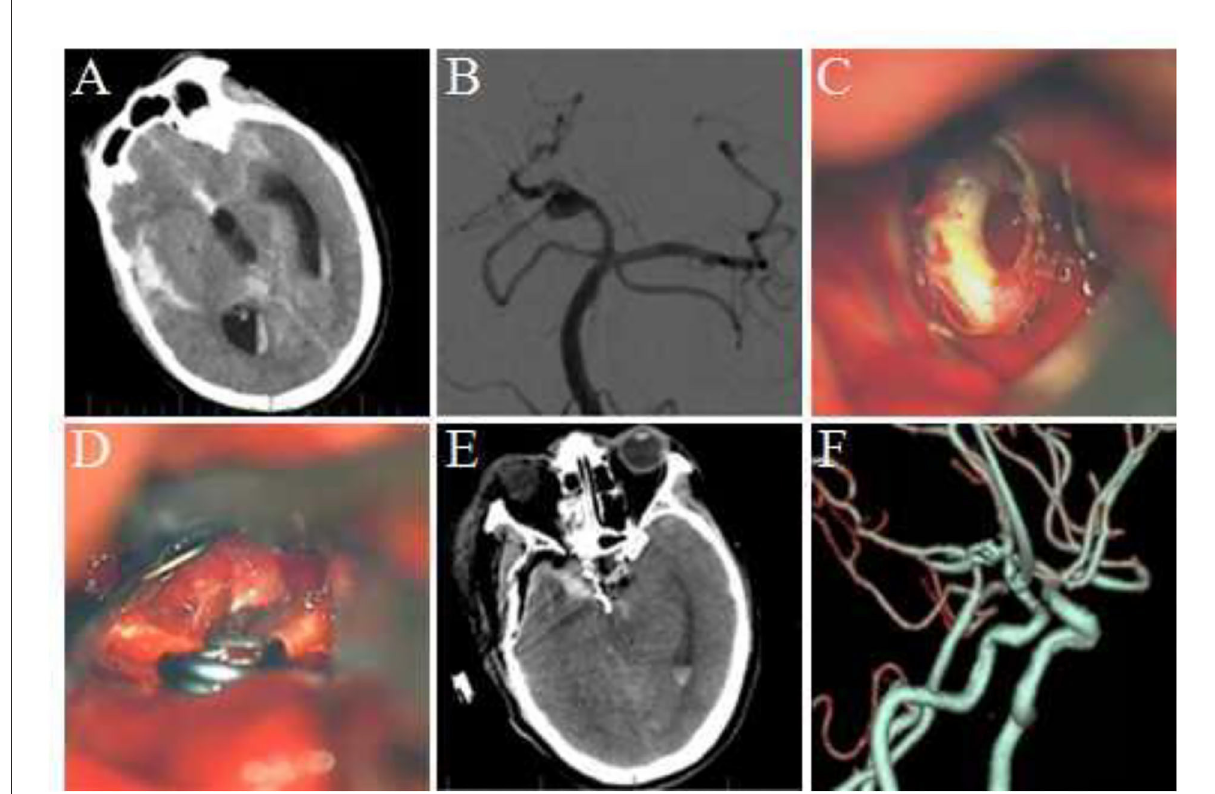
FIGURE2 Clipping of the aneurysm at the P1–P2 bifurcation of the posterior cerebral artery via the Dolenc approach. (A) Preoperative head CT revealed subarachnoid hemorrhage. (B) DSA revealed the tumor at the P1–P2 bifurcation of the right posterior cerebral artery. (C) The aneurysm was exposed during the surgery; the wall of the apical aneurysm was thin, and adhesion was observed between the aneurysm and temporal lobe. (D) The aneurysm was clipped parallel to the parent artery during the surgery. (E) Re-examination using head CT within 12h after surgery. (F) Postoperative CTA revealed no development of aneurysm and no vascular